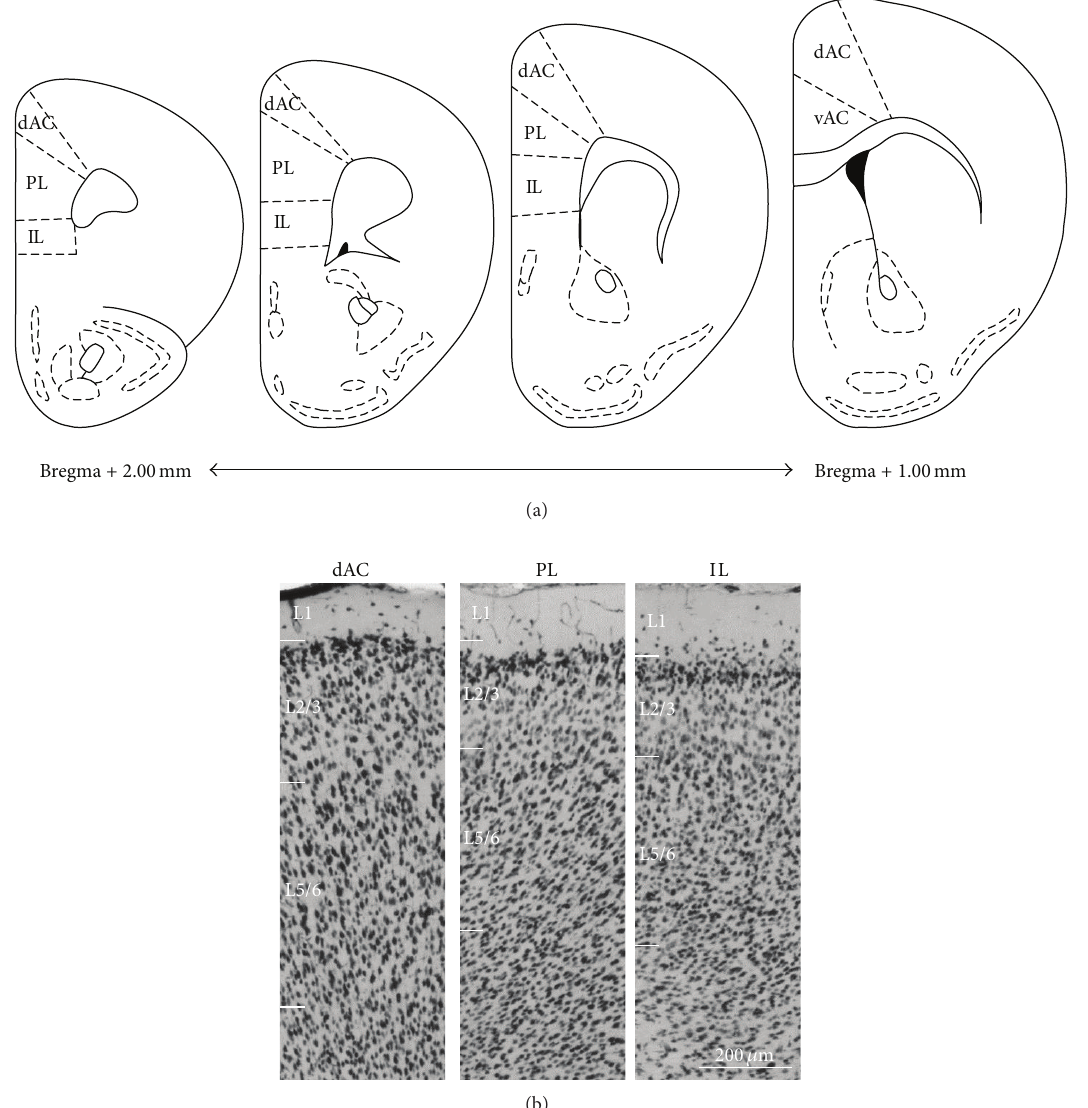
Figure 1: Anatomical characteristics of the mouse PFC. (a) Diagram depicting parcellated subareas of the PFC (PL, IL, dAC, and vAC). (b) Light micrograph illustrating the laminar distribution of NeuN-positive neurons of the PFC. Cytoarchitectural characteristics of the dAC, PL, and IL region. Scale bars = 200 𝜇